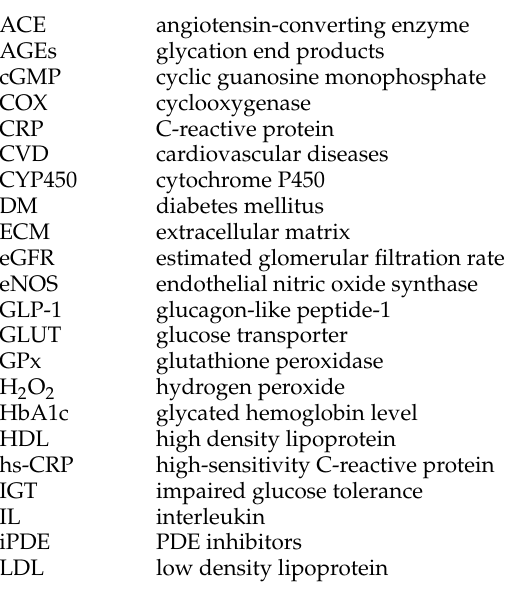
Figure 1: Thiago Melo Costa Pereira and Elisardo Corral